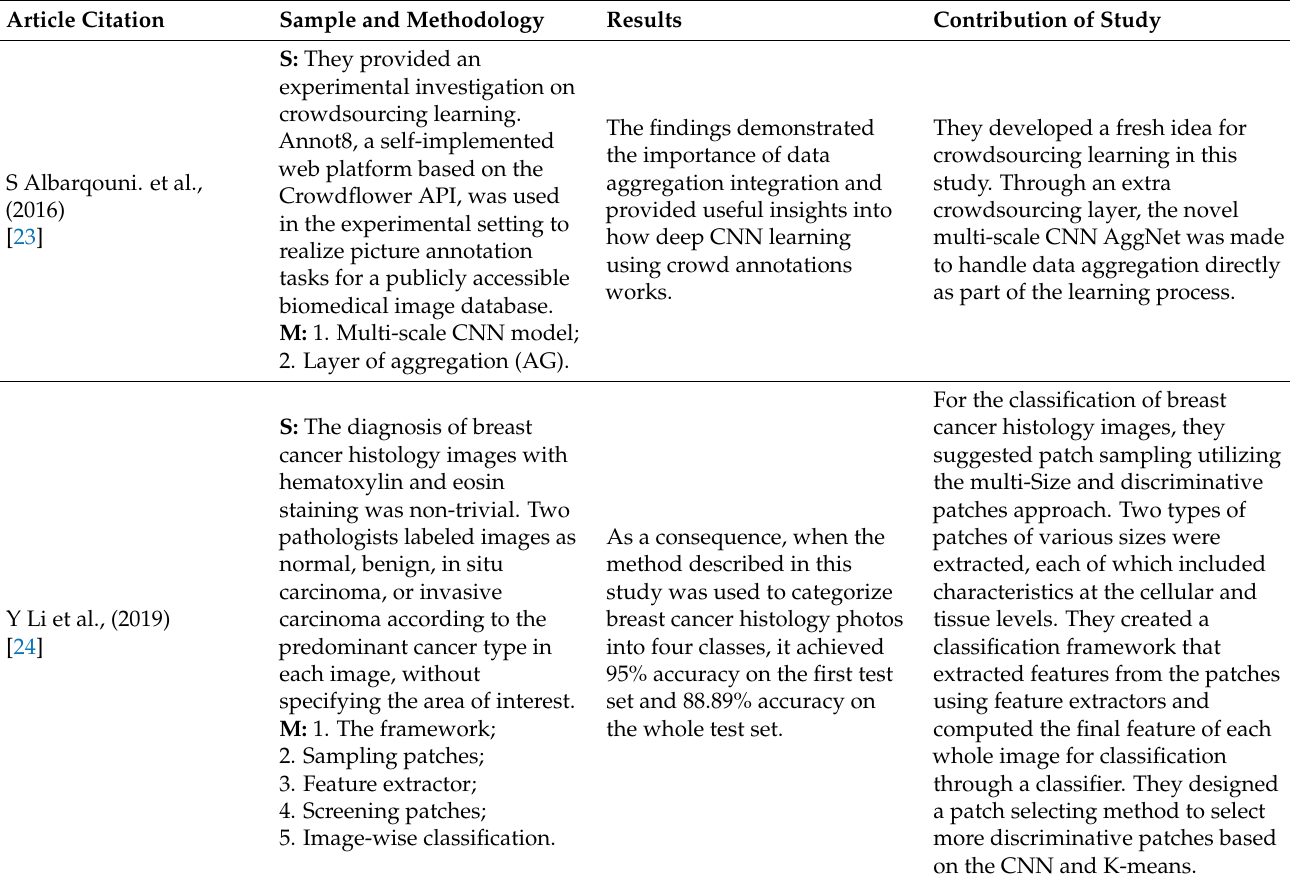
Table 1. Summary of results of previous